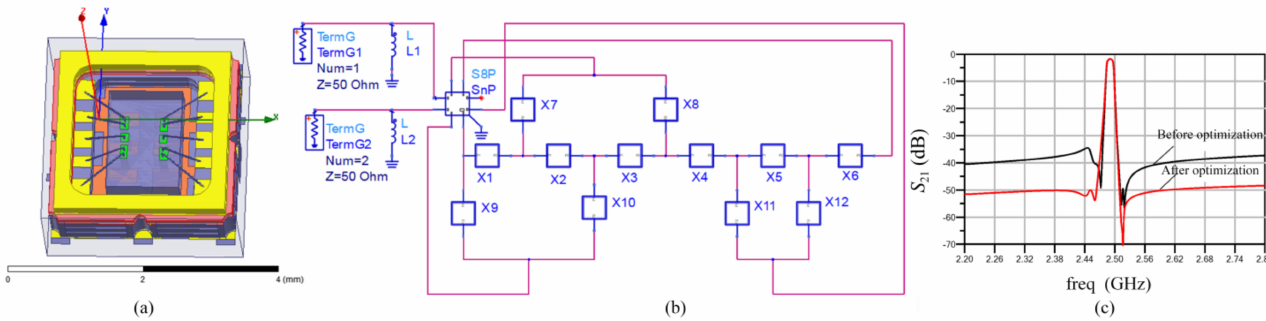
Figure 2. ( a ) HFSS model. ( b ) TC-FBAR full-wave simulation diagram. ( c ) Performance comparison after the simulation